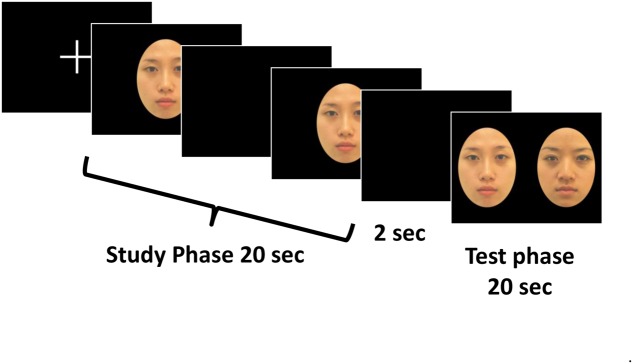
Illustration of the familiarization/visual-paired comparison (VPC) procedure used is the infant experiment.